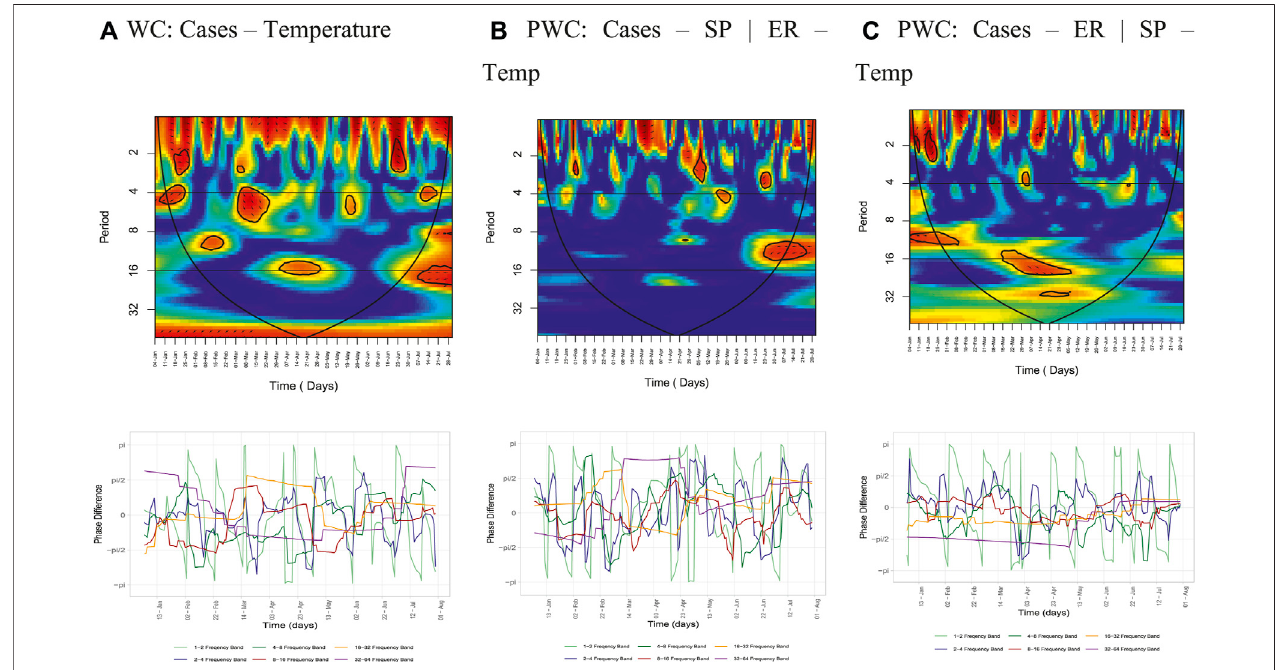
FIGURE 6 | Italy. (A) WC: Cases — Temperature. (B) PWC: Cases — SP | ER — Temp. (C) PWC: Cases — ER | SP —